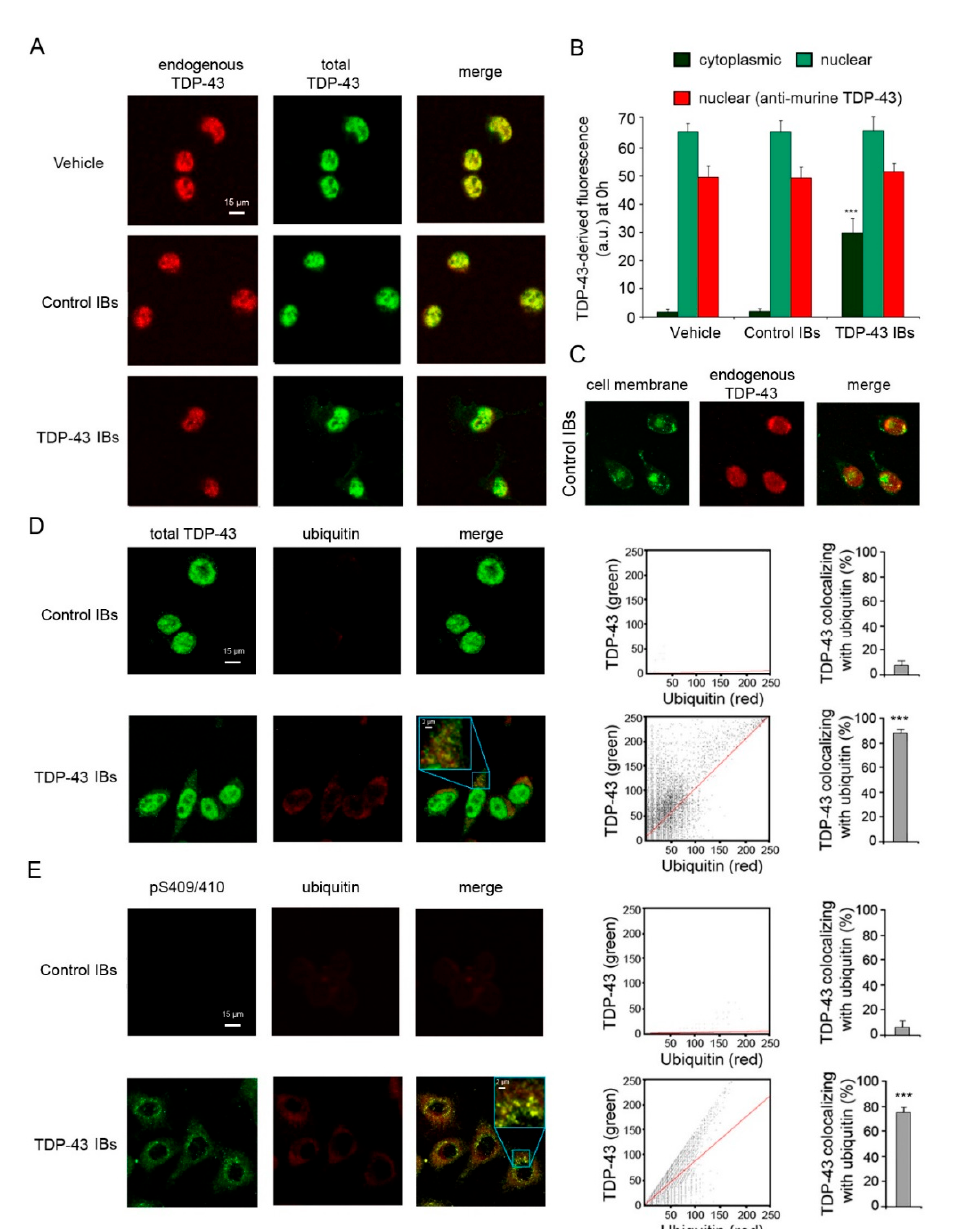
Figure 1. TDP-43 inclusions are ubiquitinated and phosphorylated in N2A neuroblastoma cells. ( A ) Representative confocal scanning microscope images of N2A cells transfected with vehicle, control IBs, and TDP-43 IBs. Red and green fluorescence indicate endogenous murine TDP-43 and total TDP-43 (human and murine), respectively, detected with immunofluorescence. ( B ) Quantitative analysis of cytoplasmic (green bars) and nuclear (pale green bars) TDP-43-derived fluorescence 0 h after transfection and using antibodies specific for total (human and murine) TDP-43. The red bars refer to nuclear TDP-43-derived fluorescence at 0 h using antibodies specific for murine TDP-43. ( C ) Representative confocal scanning microscope images of N2A cells transfected with control IBs. Green and red fluorescence indicate cell membrane and endogenous murine TDP-43, respectively. ( D , E ) Representative confocal scanning microscope images showing the co-localization of cytoplasmic TDP-43 ( D ) or TDP-43 phosphorylated at Ser409 / 410 ( E ) with ubiquitin-positive aggregates in N2A cells transfected with control IBs or TDP-43 IBs. Green and red fluorescence indicate total TDP-43 or pS409 / 410 TDP-43 and ubiquitin, respectively. Higher magnifications of the merged images are shown in the boxed areas. The cytofluorograms show the cytoplasmic green fluorescence intensity (as pixel intensity, y axis) versus cytoplasmic red fluorescence intensity (x axis). The histograms show the percentage of co-localization on regions of interest (50–60 cells) using the ImageJ and JACOP plugin software. Error bars are S.D. *** p < 0.001 relative to cells transfected with vehicle.